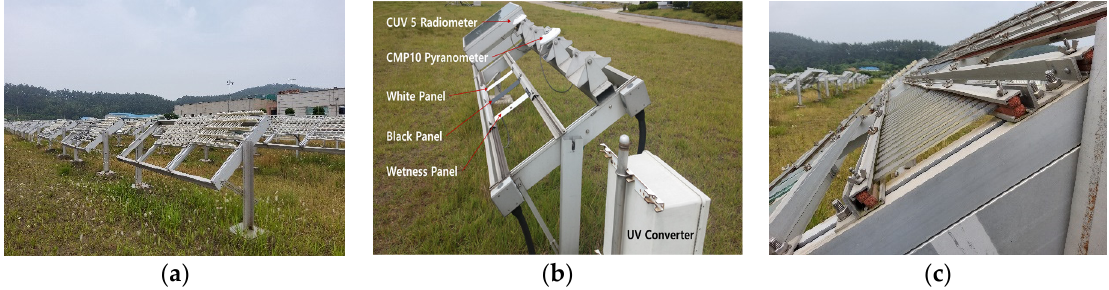
Figure 1. Outdoor weathering test at Seosan: ( a ) overall view; ( b ) integrated station; ( c ) stress-free tensile specimen mounts facing south at a 37° solar angle.